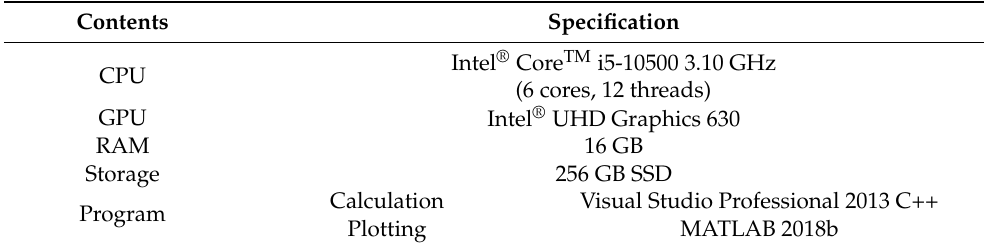
Table 4. The environment of